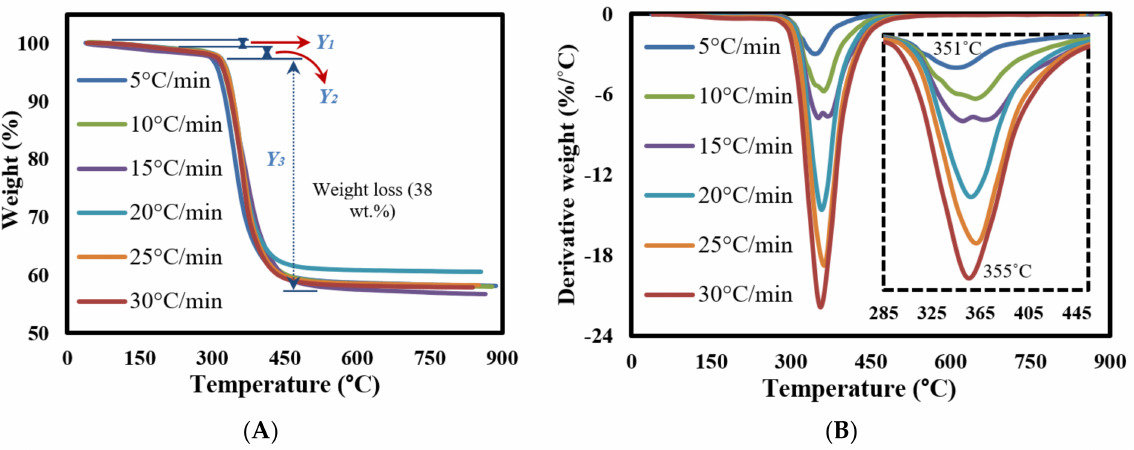
Figure 3. ( A ) TGA and ( B ) DTG curves of FGE and GFRC at different heating rates.